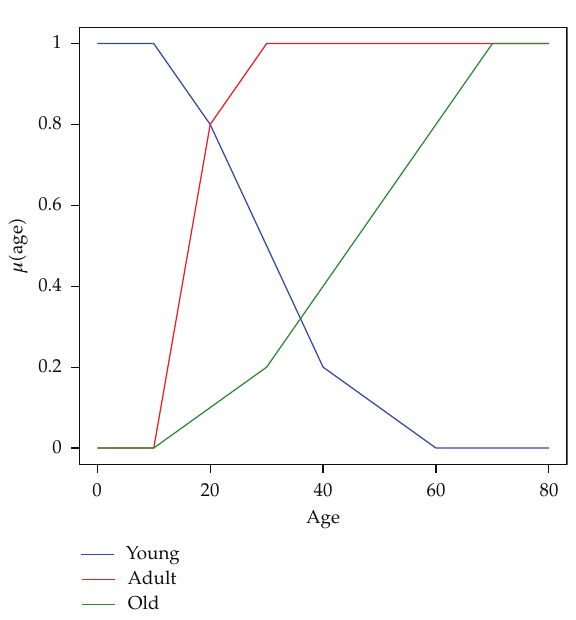
Figure 3: A graphical example of concept definitions in fuzzy